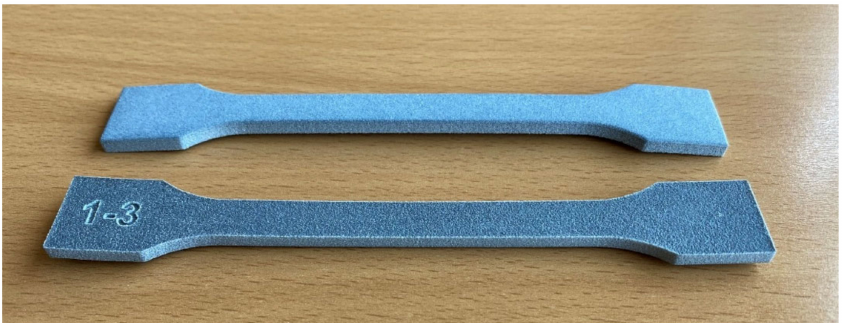
Figure 9. Bottom, warpage of the tensile bars from PET by HSS. Top, an upturned bar to show the bottom surface and the lateral surface are whiter than the top surface which is dark grey. This is due to powder adhesion from outside the build envelope caused by the necessary high energy input through the sintering lamp. The bars could be straightened for tensile measurements by placing them in an oven at 230 ◦ C with an aluminium plate on